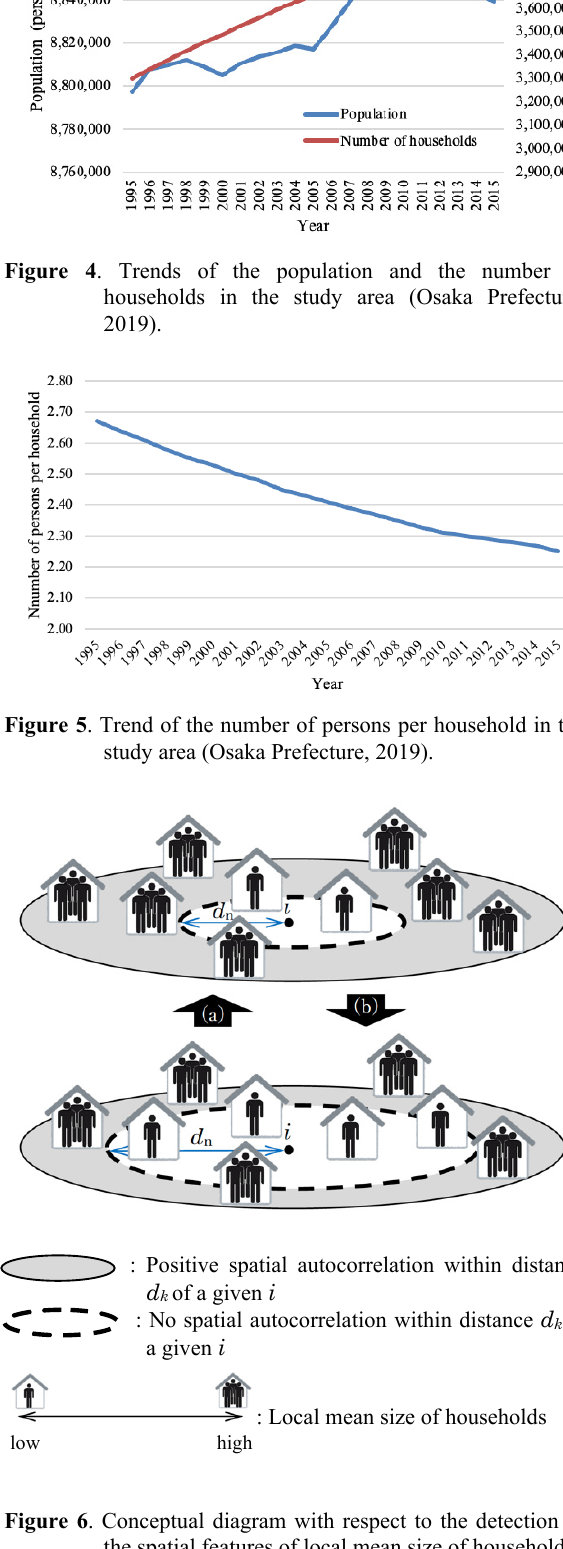
Figure 6 . Conceptual diagram with respect to the detection of the spatial features of local mean size of